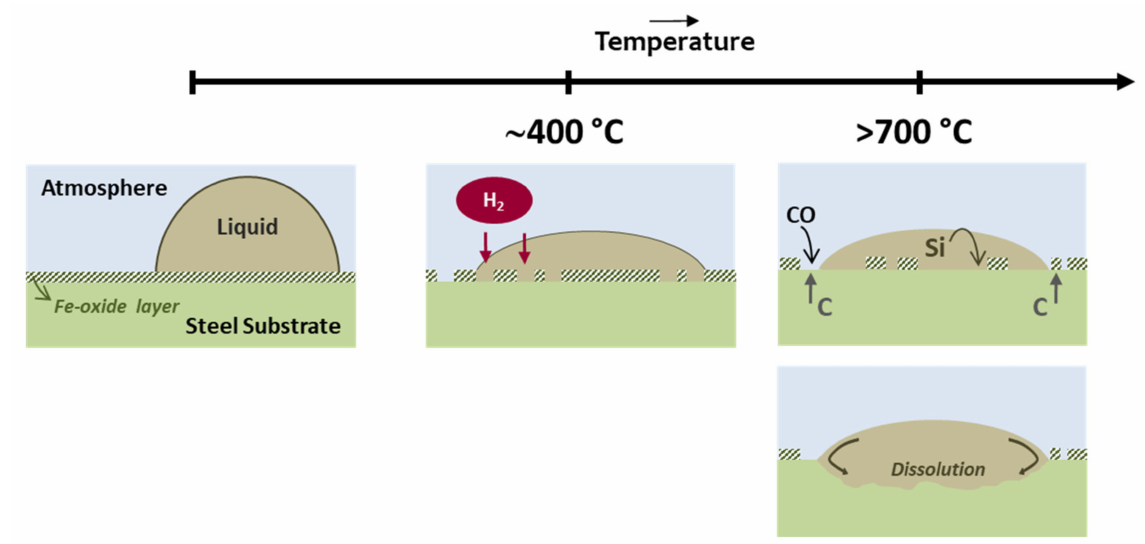
Figure 9. Scheme that illustrates the available reducing agents in a wetting system that contributes to the necessary reduction of surface oxides: at 400 ◦ C by H 2 present in the atmosphere and at higher temperatures by carbothermal reductions, metallothermic reactions and dissolution